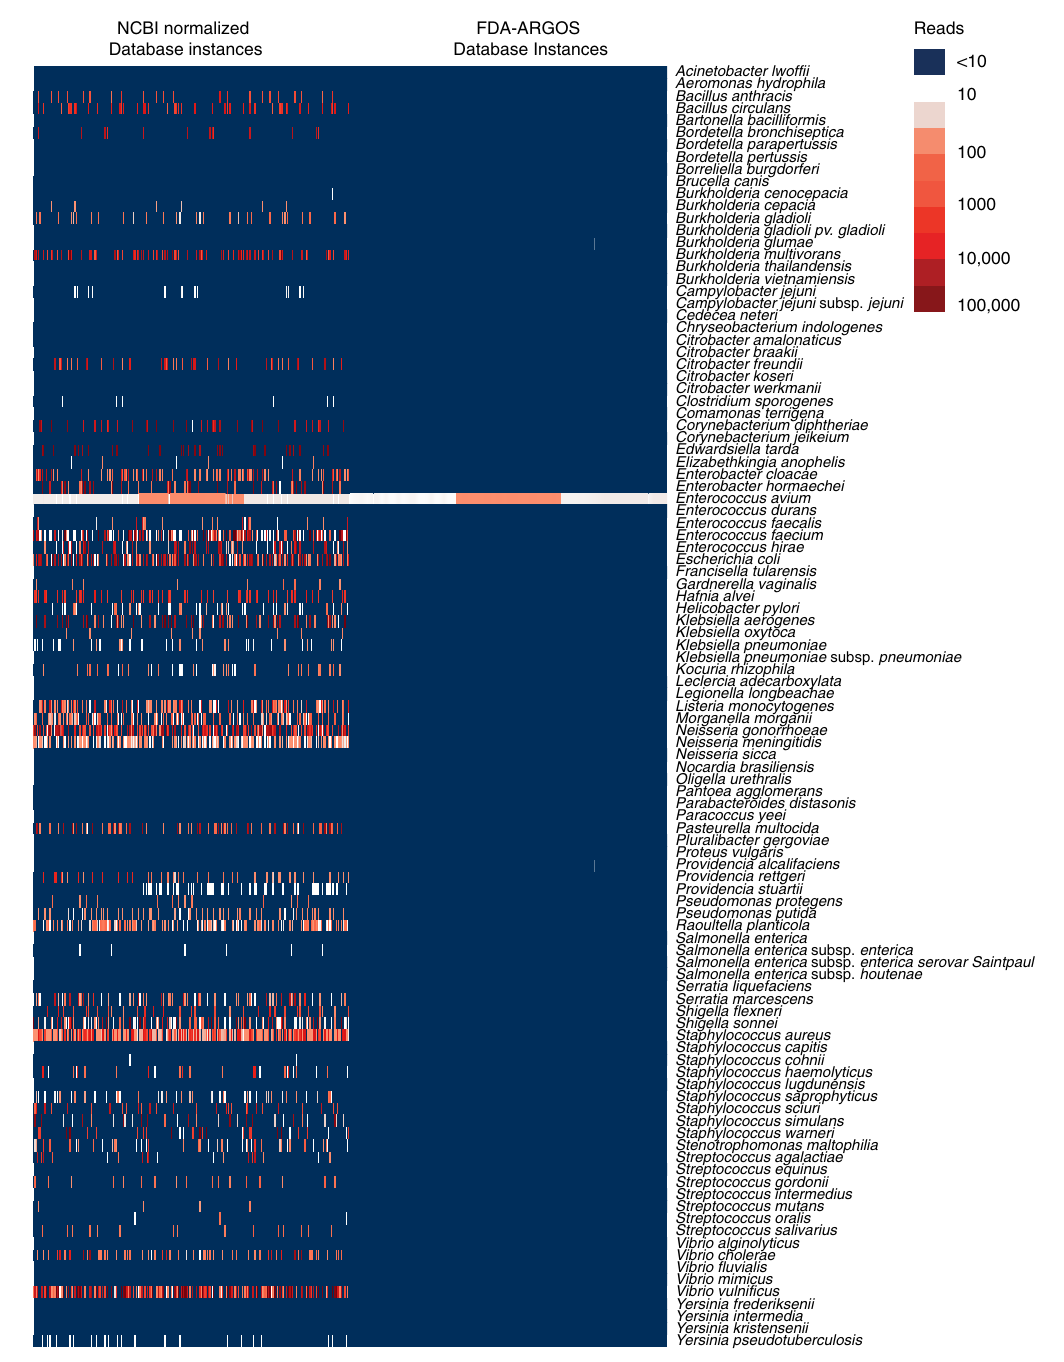
Fig. 4 Comparison of NCBI Nt and FDA-ARGOS read classi fi cation results. Visualizing bioinformatics analysis with the MegaBLAST tool of metagenomics shotgun data of mock clinical human blood sample spiked with 10 5 E. avium . The heatmap showed read classi fi cation results for triplicate samples run against 200 database instances. Dark blue indicates read numbers below 10. A gradient from white to red indicates read numbers ranging from above 10 to 100,000. Here we demonstrated read classi fi cation results for all simulated species. E. avium classi fi cation results were consistent across all database instances. In addition, several other species were classi fi ed at >1000 reads with the normalized NCBI Nt database instances (Supplementary Data 3 and